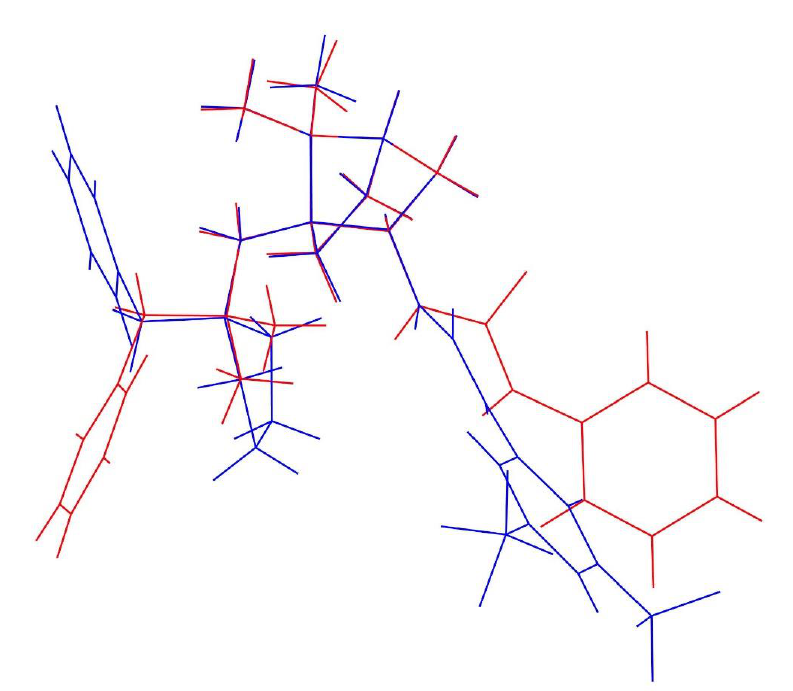
Figure 3. Stick presentation of the superimposed molecular structures of products III (blue) and VI-Br (red).